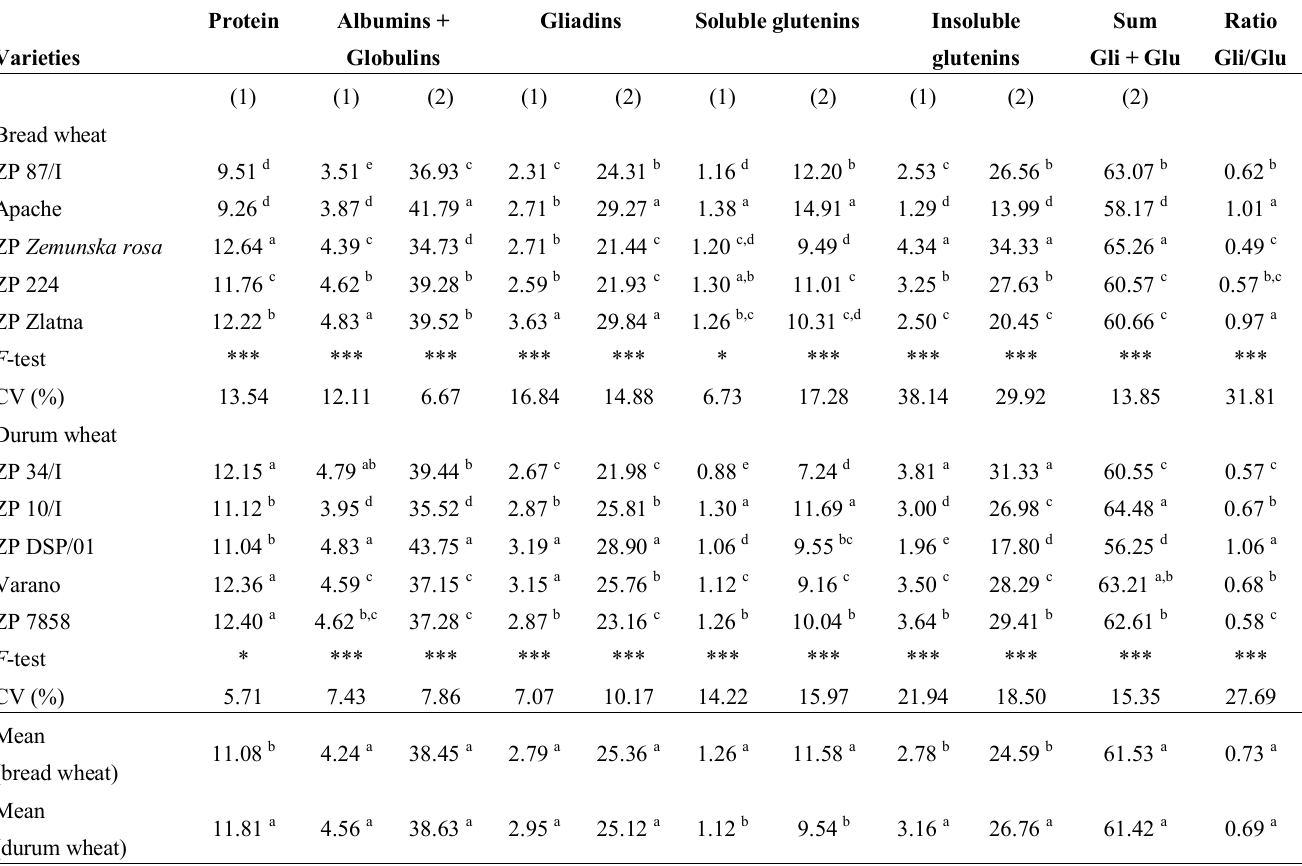
Mean of genotypes and species followed by the same letter within same column are not significantly different ( P < 0.05); * = significant at P < 0.05; *** Significant at P < 0.001; CV, coefficient of variation; (1) % of dry weight; (2) %